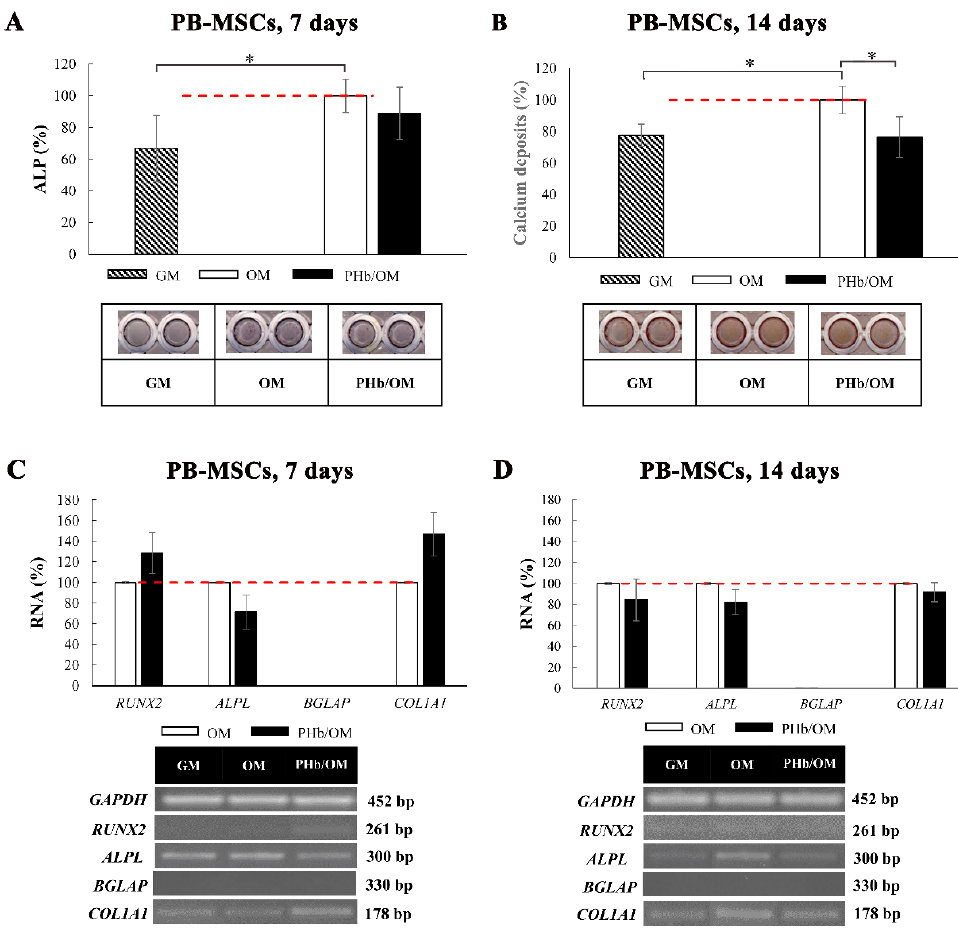
Figure 5. Acellular porcine hemoglobin (PHb) reduces osteogenic differentiation capacity of primary PB-MSCs. Osteogenic differentiation of PB-MSCs was assessed by ALP staining (NBT/BCIP) after 7 days in culture ( A ) and Alizarin red staining after 14 days in culture ( B ) with or without 0.1 µM PHb in osteogenic differentiation medium (OM). Intensity of ALP or Alizarin red staining is presented as relative to corresponding control (OM set as 100%). Mean ± SD of four independent experiments is shown; * p < 0.05, compared to the control (OM). Osteogenic differentiation of PB-MSCs was confirmed by RT-PCR of analysis of expression of RUNX2 , ALPL , BGLAP , COL1A1 genes after the cells were cultured in OM with and without PHb for 7 days ( C ) and 14 days ( D ). GAPDH was used as a gel loading control. Representative RT-PCR bands are shown. The RT-PCR results are expressed as relative to corresponding control (OM, set as 100%). Mean ± SD of three independent experiments is shown.